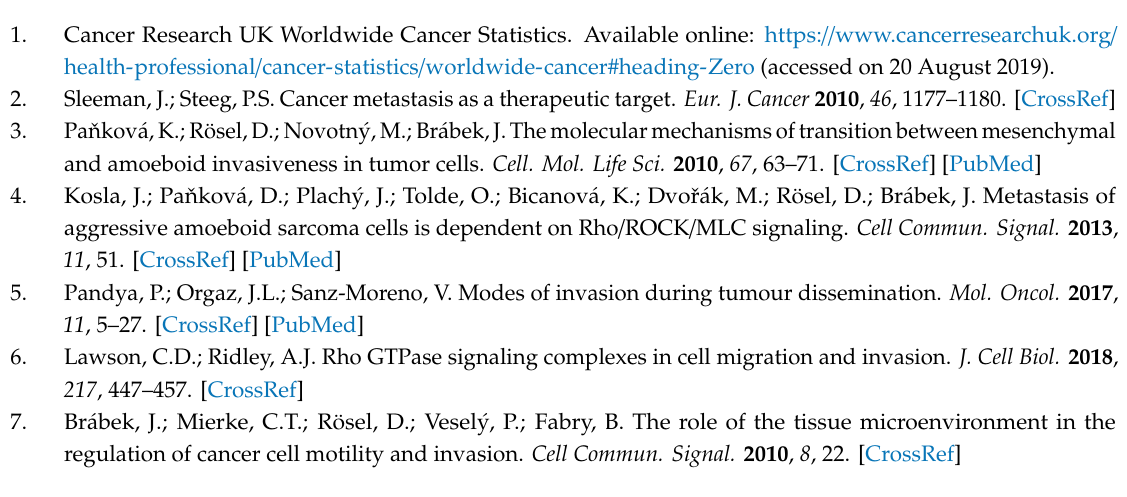
Figure S1: Transcriptomic overlaps of only 3 datasets used for meta-analysis, Figure S2: RT-qPCR analysis of NEAT1 and second pair of primers for MALAT1 in cells undergoing MAT, Figure S3: Complementary RT-qPCR quantification of MALAT1 level in clones derived from A375m2 and A2058 cell lines and quantification of cell morphology of A2058 cells after treatment with Y-27632, Figure S4: Uncropped Western blots used in the study, Table S1: RT-qPCR primers used in the work, Table S2: Reference genes used for respective cell lines in RT-qPCR analysis, File S1: data used for the comparison of transcriptomic